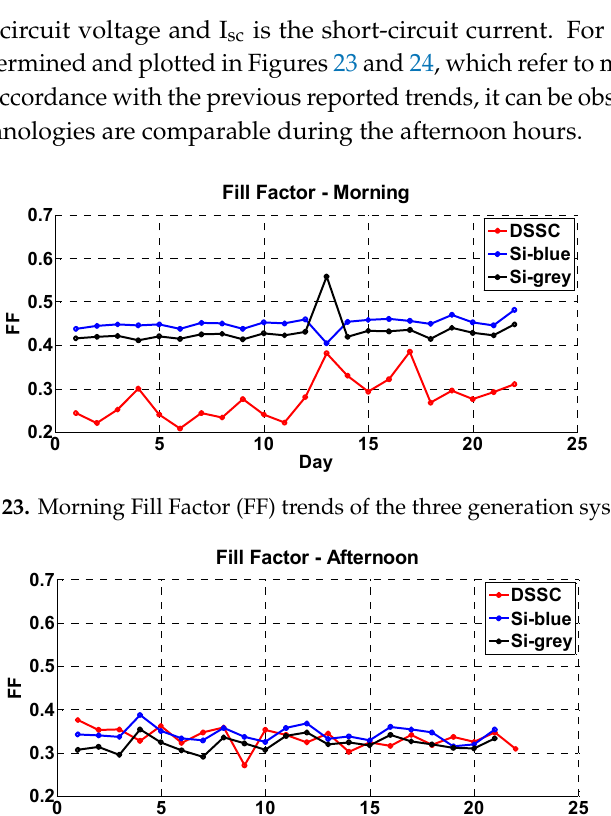
Figure 22. Afternoon power trends of the three generation systems.